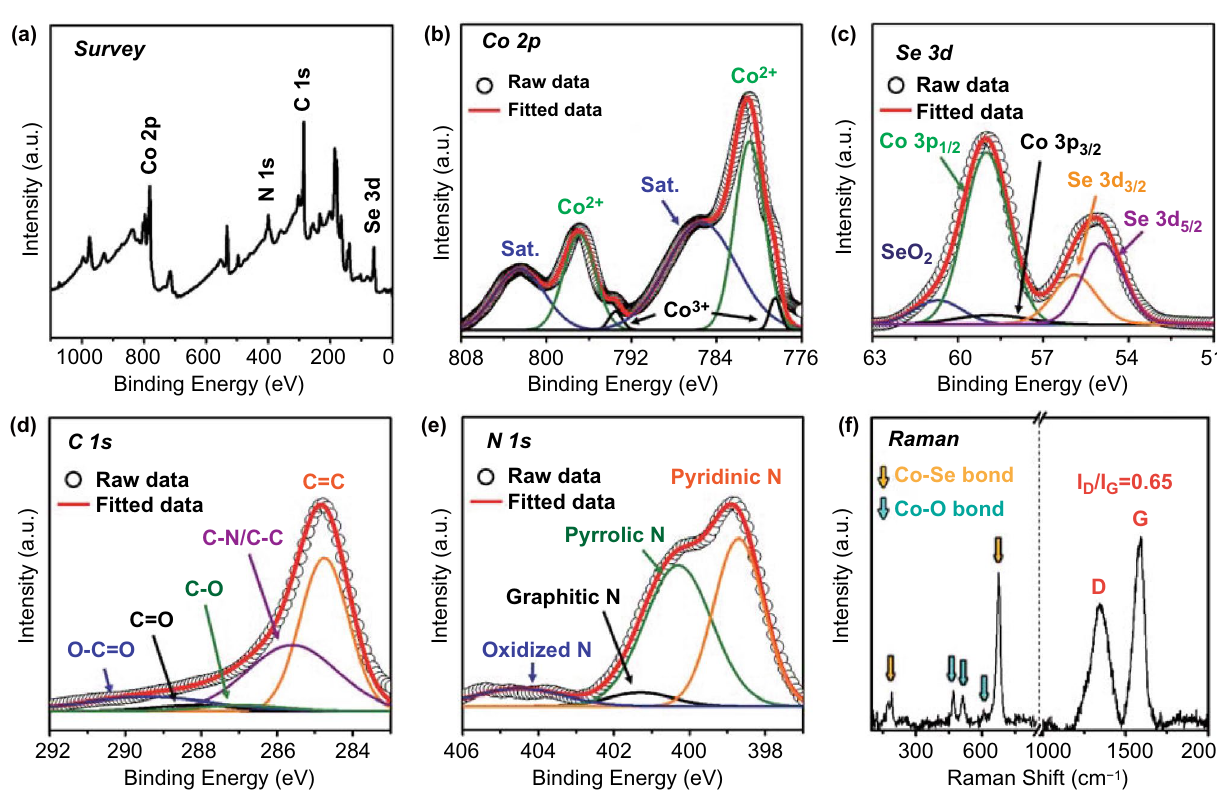
Fig. 4 XPS survey spectrum, core-level XPS spectra, and Raman spectrum: a XPS survey spectrum, b Co 2 p , c Se 3 d , d C 1 s , e N 1 s , and f Raman spectrum of the P-CoSe 2 @PDA-C NR